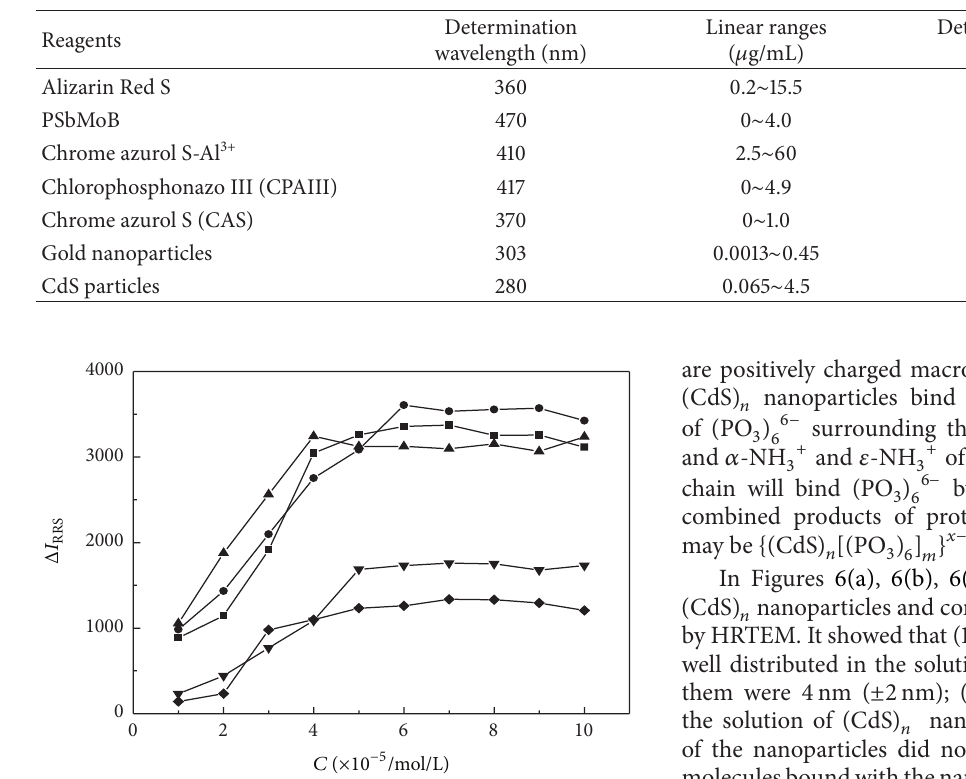
Table 2: Comparison of sensitivities of some RRS methods for the determination of HSA.